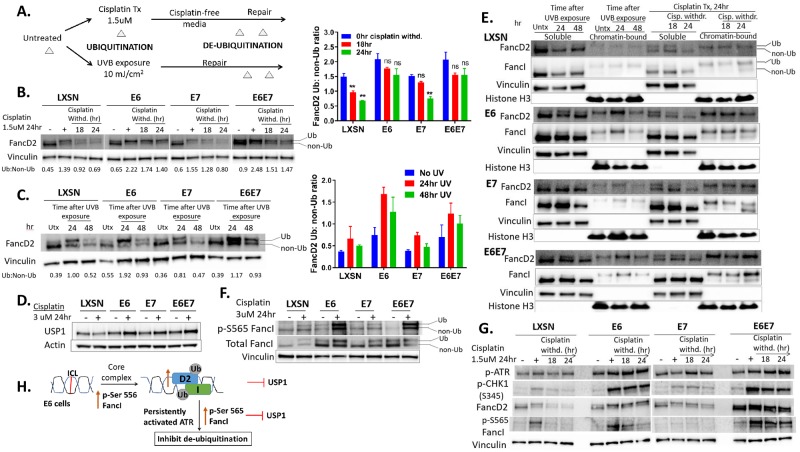
HPV E6 causes delayed de-ubiquitination of FancD2.(A) Outline of an experiment to evaluate FancD2 monoubiquitination/de-ubiquitination pattern. Transduced HFK cells were untreated or treated with cisplatin (1.5 uM for 24 hr) or exposed to 10 mJ/cm2 UVB and allowed to repair. Whole-cell lysates were prepared for immunoblot at various time points during the experiments (represented by Δ). (B-C) Immunoblots of HFKs subjected to the experiment outlined in Fig 4A, following cisplatin withdrawal (B) or recovery after UVB exposure (C). Ratios of monoubiquitinated to non-ubiquitinated FancD2 (D2 Ub: non-Ub) are indicated beneath the corresponding lanes. FancD2 Ub:non-Ub ratio in cells following cisplatin withdrawal and UVB exposure was plotted alongside Figure 5B and 5C. ** (p< 0.01) denotes a statistically significant difference from 0 hr cisplatin withdrawal. ‘ns’ denotes non-significant differences. (D) USP1 immunoblot in cells untreated and treated with cisplatin. (E) Immunoblot of soluble and chromatin-bound fractions prepared from transduced HFK cells subjected to the experiment outlined in Fig 6A. Vinculin and Histone H3 act as loading controls respectively for soluble and chromatin-bound fractions. (F) Immunoblot showing levels of p-FancI-S565 and total FancI in cisplatin-treated or untreated cells. (G) Immunoblot for p-ATR, pCHK1, FancD2 and p-FancI-S565 following cisplatin withdrawal for 18 and 24 hrs. Actin or vinculin act as a loading control for immunoblots (B-G). (H) Proposed mechanisms for delayed de-ubiquitination of FancD2 in E6 cells.